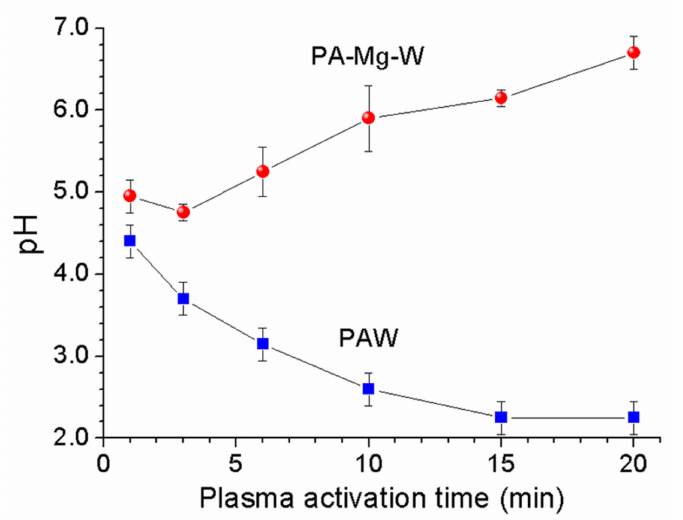
Figure 3. The pH of the PAW and PA-Mg-W as a function of the plasma activation time.